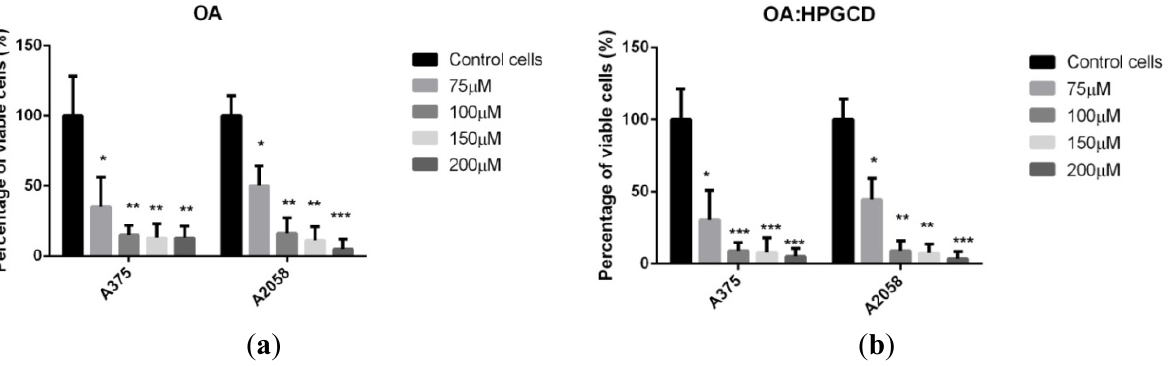
Figure 3. Alamar Blue assay showing the effects of ( a ) OA and ( b ) OA:HPGCD complex, respectively, on the viability of the A375 and A2058 human melanoma cell lines. Viability is expressed as percentage of viable cells compared to the control (considered as